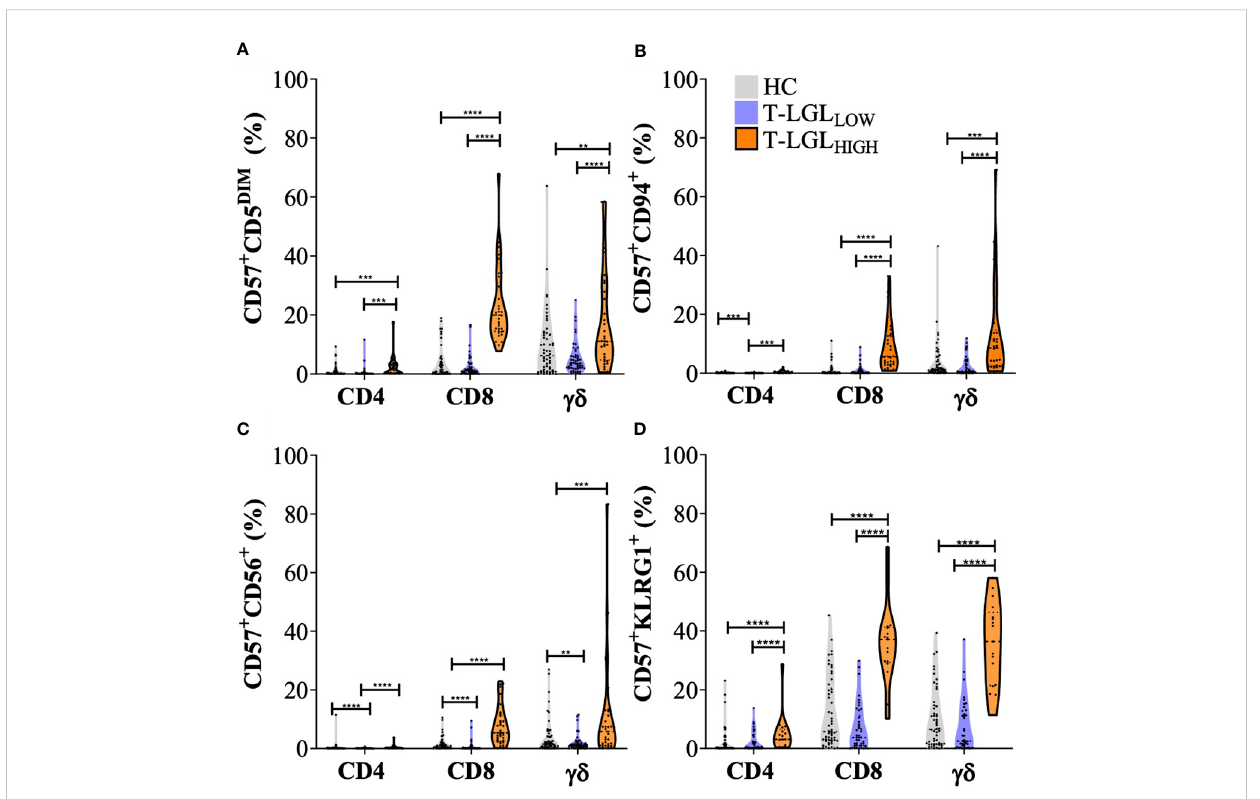
FIGURE 5 Immunophenotyping of T cell populations in healthy controls, IBM T-LGL LOW , and IBM T-LGL HIGH . Frequency of CD57 + CD5 DIM cells (A) , CD94 + T cells (B) , CD56 + T cells (C) , and KLRG1 + cells (D) in CD4 + , CD8 + and gd T cells (identi fi ed as CD3 + , TCR ab - cells). Statistical analysis was